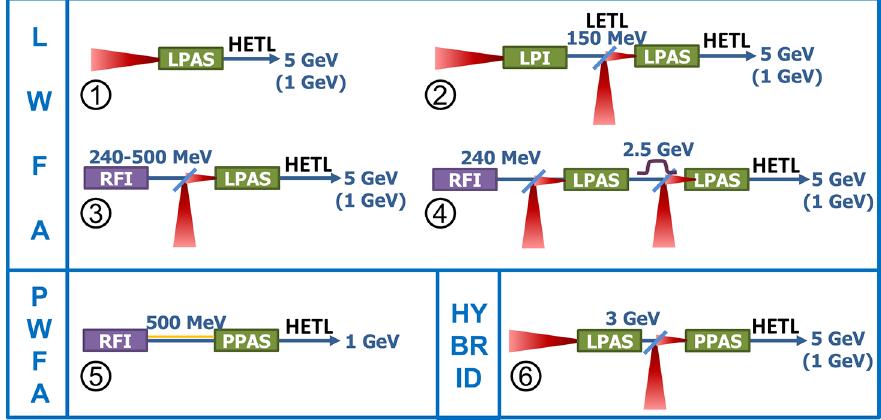
FIG. 1. The injection and acceleration schemes under investigation. RFI stands for radio-frequency injector, LPI for laser-plasma injector, LPAS for laser-plasma acceleration stage, and PPAS for particle-plasma acceleration stage. LETL and HETL stand for low- energy and high-energy transfer lines, respectively. Schemes 1 – 4 are related to laser-driven wakefield acceleration where the laser beam is represented in red. Scheme 5 is related to particle-driven wakefield acceleration. Scheme 6 is related to a hybrid configuration mixing laser-driven and beam-driven